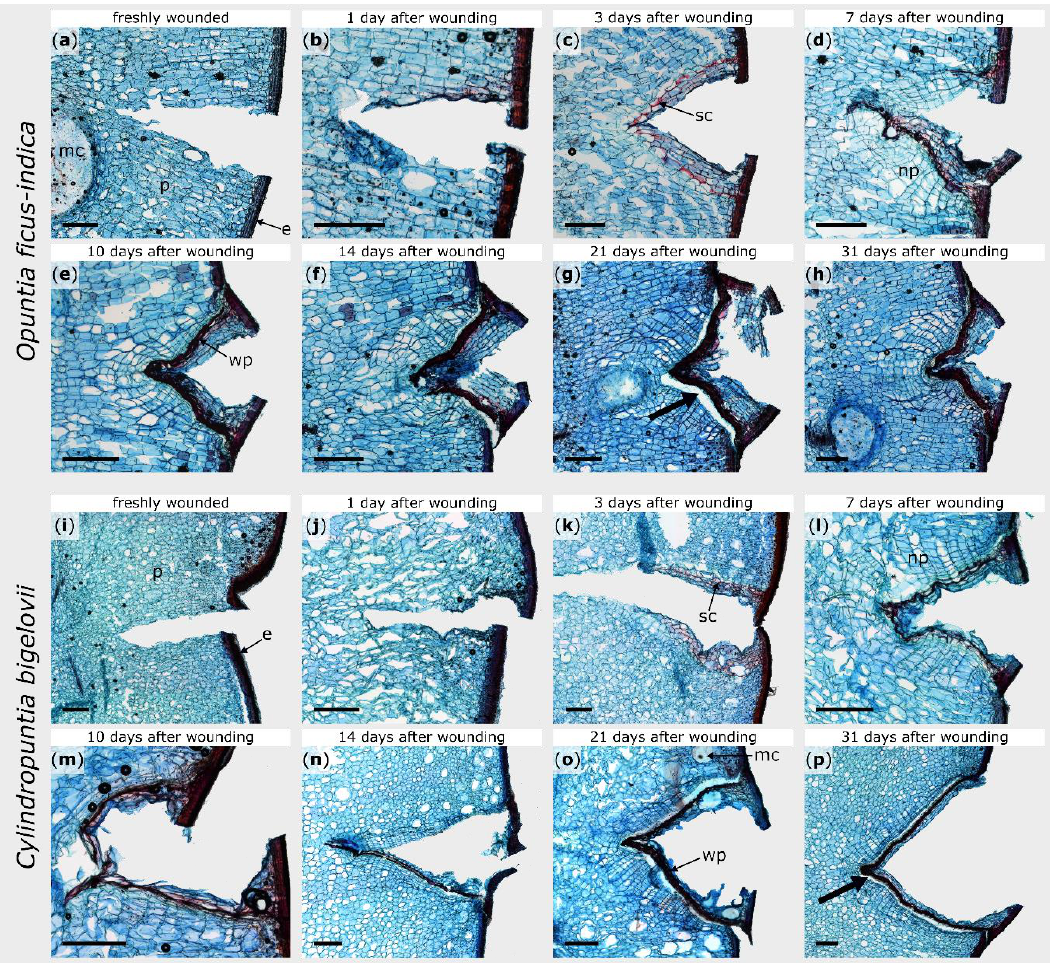
Figure 2. Tangential sections of wound areas after artificial ring incision in Opuntia ficus-indica ( a – h ) and Cylindropuntia bigelovii ( i – p ), stained with safranin O and Astra blue. The sections were microscopically examined directly after wounding ( a , i ), after a healing period of 1 day ( b , j ), 3 days ( c , k ), 7 days ( d , l ), 10 days ( e , m ), 14 days ( f , n ), 21 days ( g , o ), and 31 days ( h , p ). Cellulose cell walls appear blue, ligno-suberized cell walls appear red. e: epidermal and hypodermal layers, mc: mucilage cell, np: newly formed parenchyma, p: parenchyma, sc: suberized cells, wp: wound periderm. The bold arrows indicate exemplarily the areas where the phellogen has detached from the phelloderm caused by the mechanical stresses during the preparation of the section. Scale bars = 500 µ